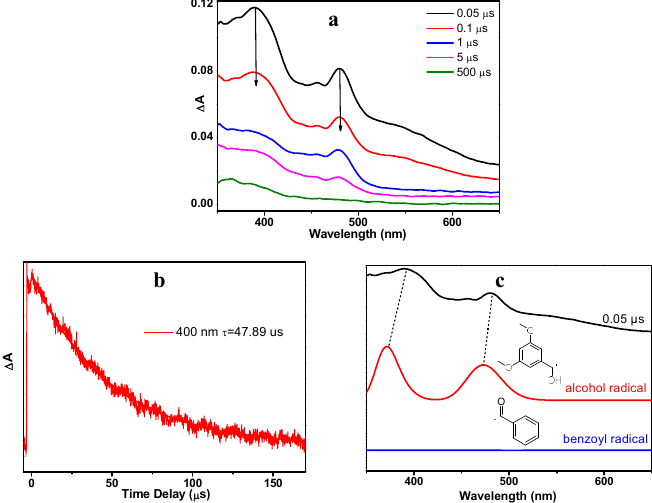
Figure 6. ( a ) ns-TA (nanosecond transient absorption) spectra of DMB in MeCN after 355 nm irradiation. ( b ) Transient decay of DMB in MeCN monitored at 480 nm. ( c ) Comparison of the computed absorption spectra of alcohol radical and benzoyl radical with the ns-TA spectrum recorded at 0.05 µ s. The calculations were performed at the TD-B3LYP / 6-311 + g(d,p) (MeCN) level of theory. The scale factor is 1.05 (applied to energy ( x -axis)) and the half-width is 1000 cm −1 .